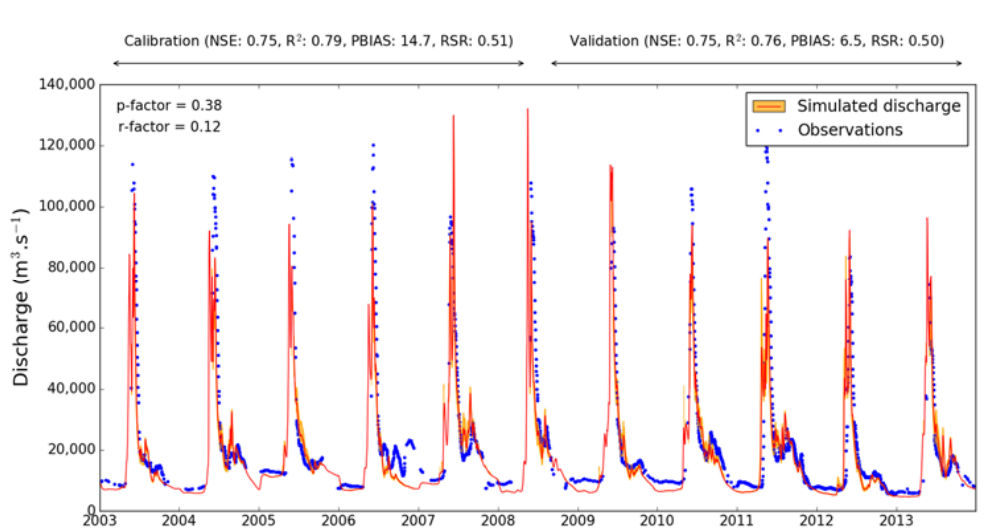
Figure 1. Daily simulated hydrograph compared to daily observations at the Yenisei outlet with goodness of indices. In orange is represented the 95PPU zone resulting from the last SWAT-CUP run. We observe a good dynamic and a good representation of spring